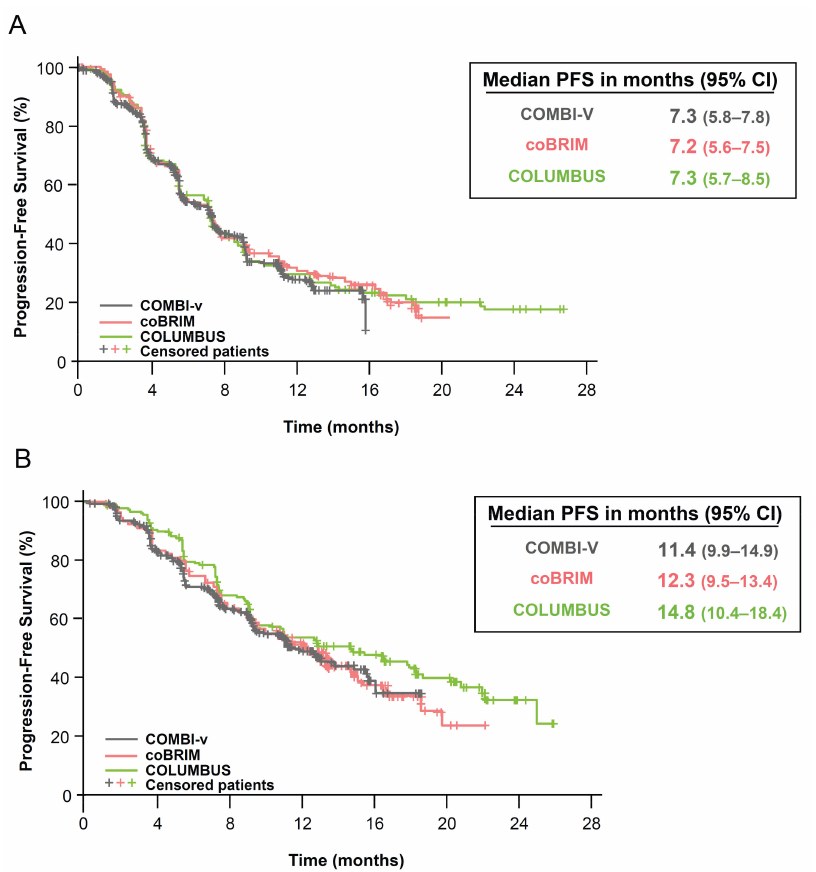
Figure 1. Local assessment of progression-free survival in ( A ) vemurafenib arms and ( B ) BRAFi / MEKi combination arms of COMBI-v, coBRIM, and COLUMBUS trials. CI indicates confidence interval; PFS, progression-free survival. Kaplan-Meier curves of progression-free survival from the vemurafenib arms and combination arms were